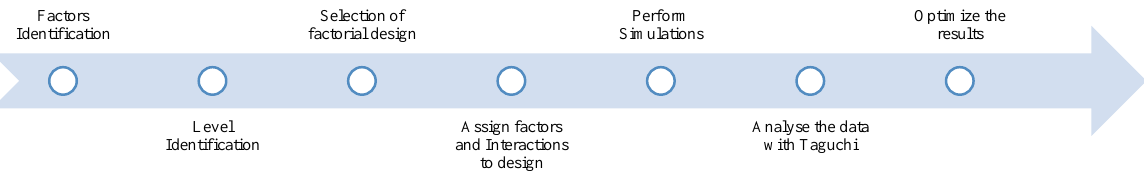
Table 2. Mesh Independence Study.